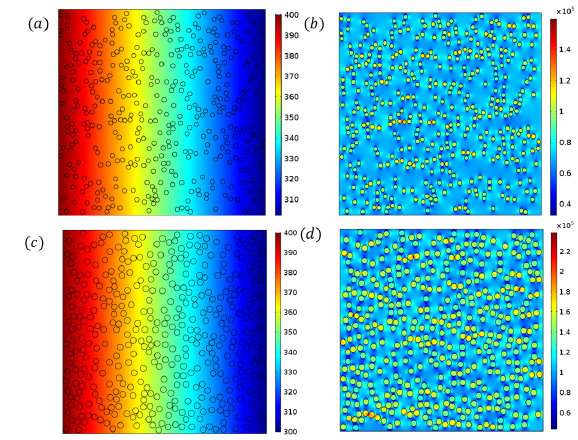
Figure 10: Distributions of temperature and heat flux component along the x -direction in the unit cells with 400 randomly dispersed fibers for v f = 14% and